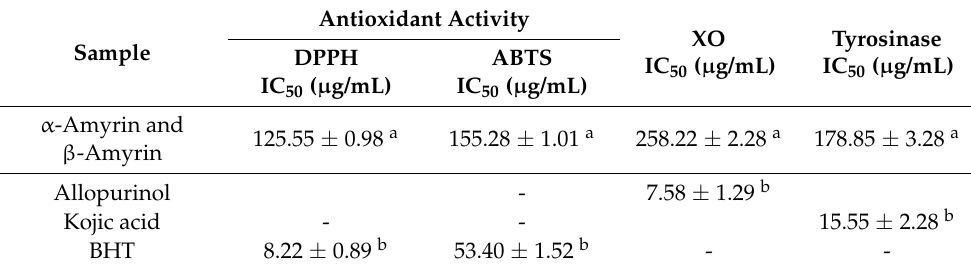
Table 4. Antioxidant, XO, and tyrosinase inhibitory capacities of α -amyrin and β -amyrin isolated from C. hindsii